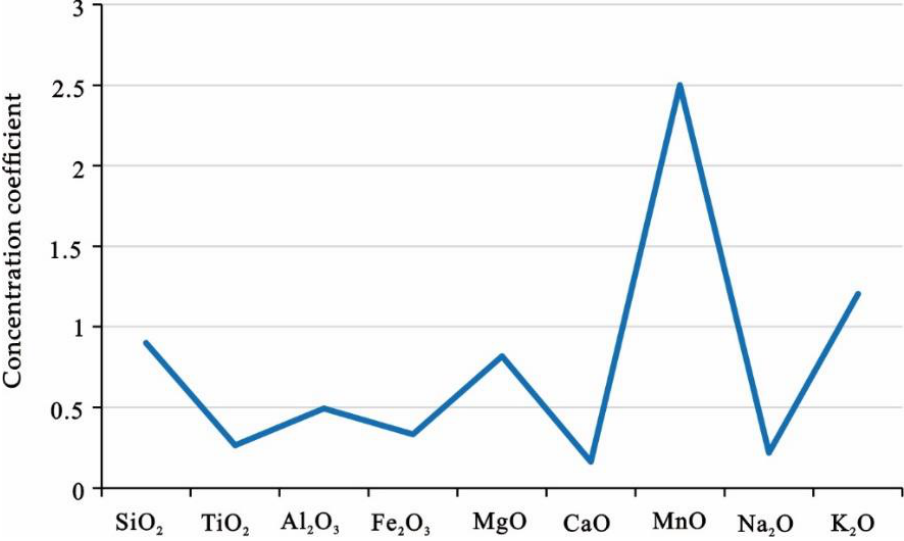
Figure 4. Concentration coefficient (CC) [22] of MEO in No. 26 coals. Table 3. The concentration of MEO in No. 26 coals, on a whole coal basis